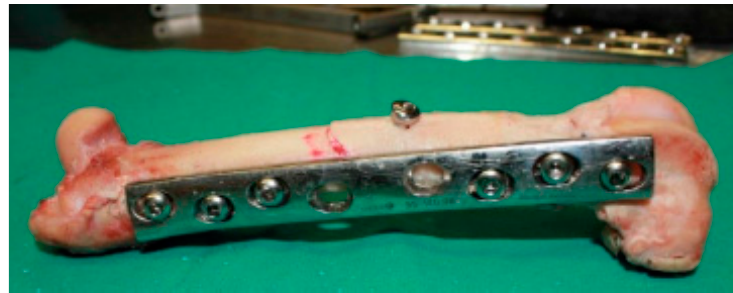
Figure 4. Fixation of the DCP plate to the femur shaft.